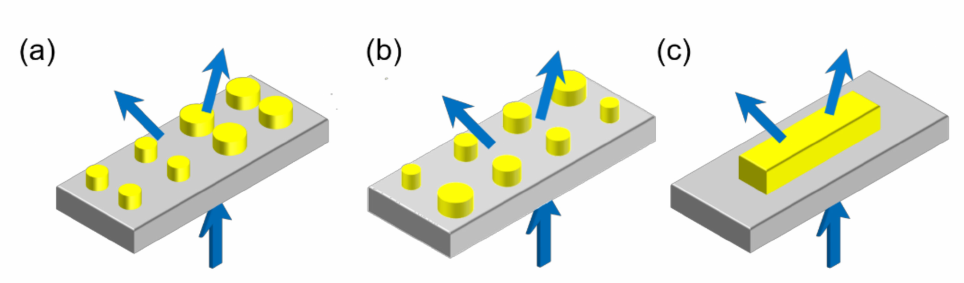
Figure 1. ( a ) Beam splitter based on a metasurface composed of binary unit cell arrays. ( b ) Beam splitter based on a discrete metasurface composed of two antenna arrays with opposite phase gradients. ( c ) Beam splitter based on a uniform